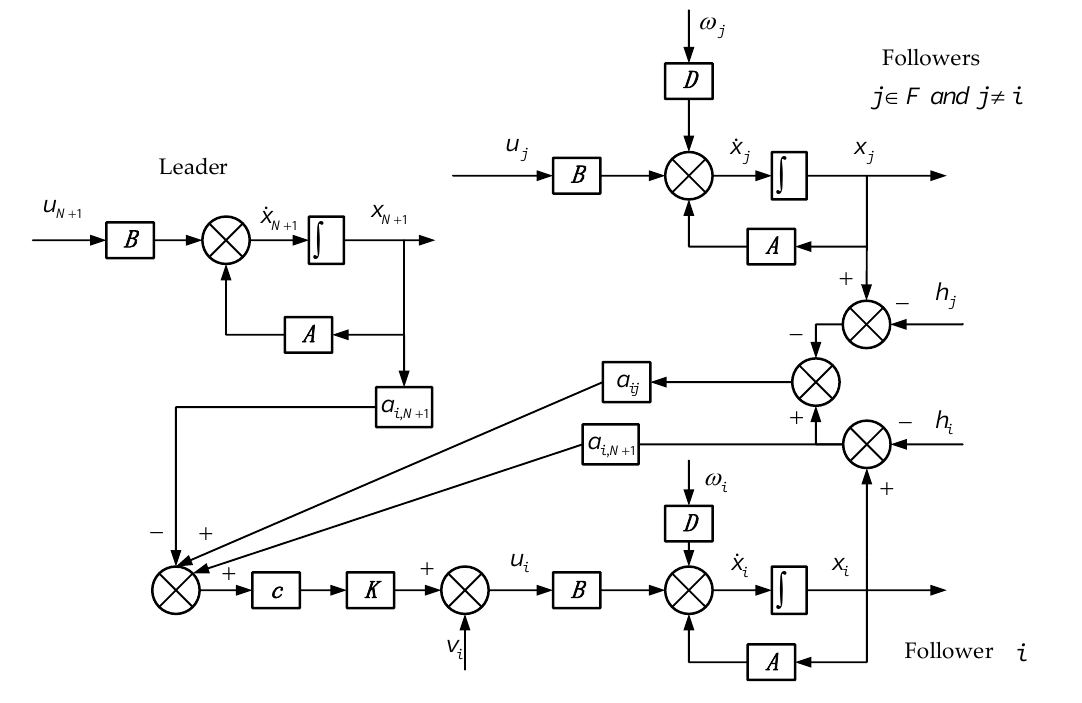
Figure 1. The sketch for the proposed control structure.